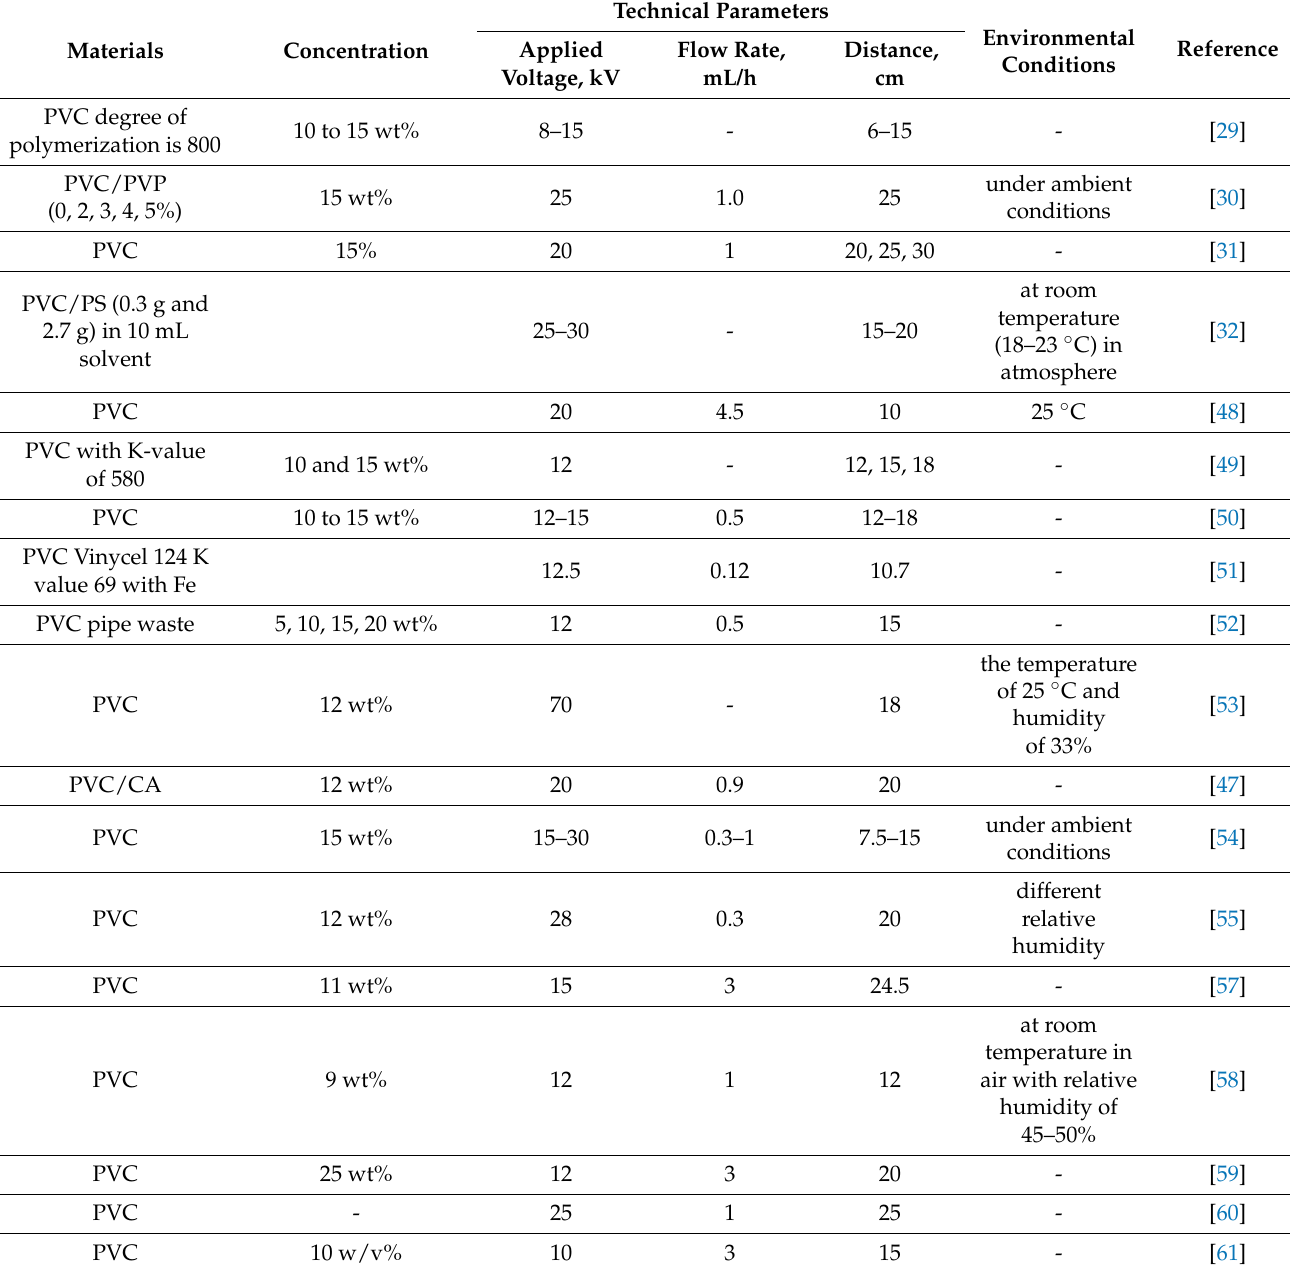
Table 2. Summary of the studies performed on electrospun